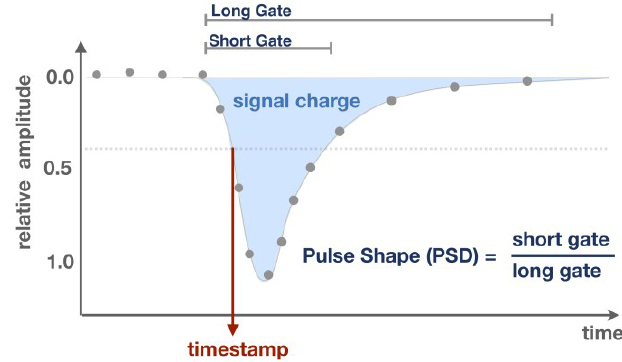
Figure 2. The voltage pulses coming from the two photomultiplier tubes are digitized by an analogue-to-digital converter (125 MHz, 14 Bit) and processed by a field programmable gate array (FPGA). In the sketch the three individual analysis parameter are shown: (1) the timestamp, which determines the arrival time of the detected event, (2) the pulse charge, which is the integral over the signal and proportional to the deposited energy and (3) the pulse shape parameter (PSD), which represents the shape of the signal.